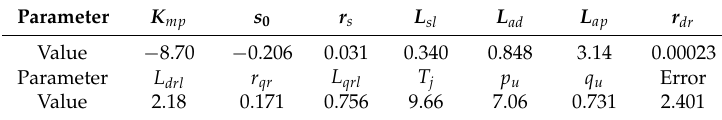
Figure 5. ( a ) The active power dynamics of the detailed model and the equivalent model of the Microgrid. ( b ) The reactive power dynamics of the detailed model and the equivalent model of the Microgrid. Table 1. A group of feasible parameters for the equivalent model.